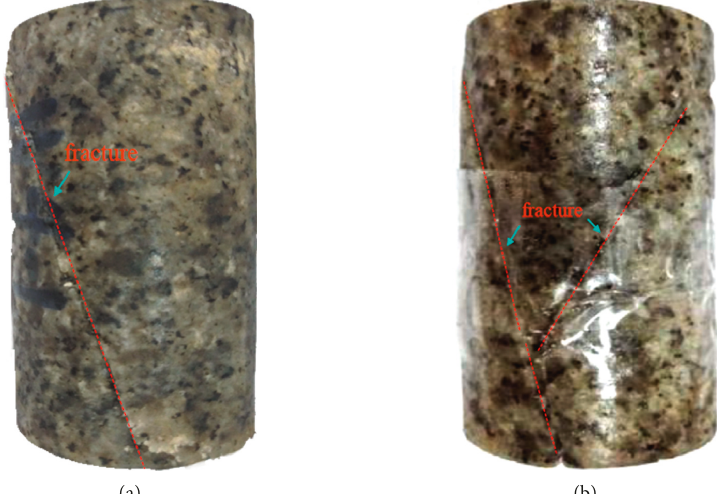
Figure 6: Comparisons of failure modes of samples under triaxial compression. (a) Monotonic loading. (b) Cyclic